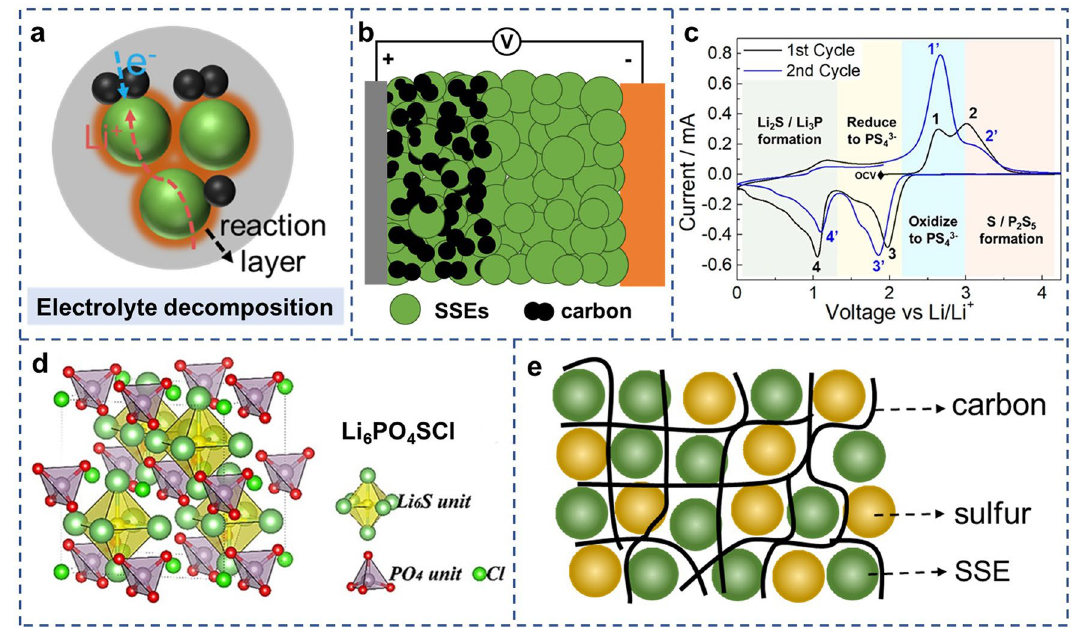
Fig. 2 Schematic diagram of a SSEs decomposition in ASSLSBs and b all-solid-state battery using SSEs-C electrodes. c Cyclic voltammo- grams of Li −